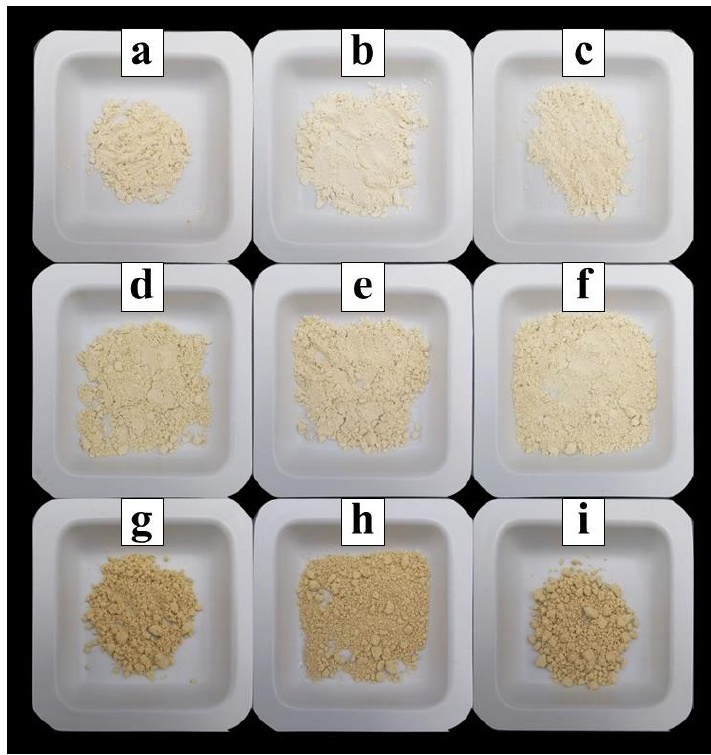
Fig. 2: Physical appearance of S1 (a), S2 (b), S3 (c), S4 (d), S5 (e), S6 (f), S7 (g), S8 (h), S9 (i) formulations.